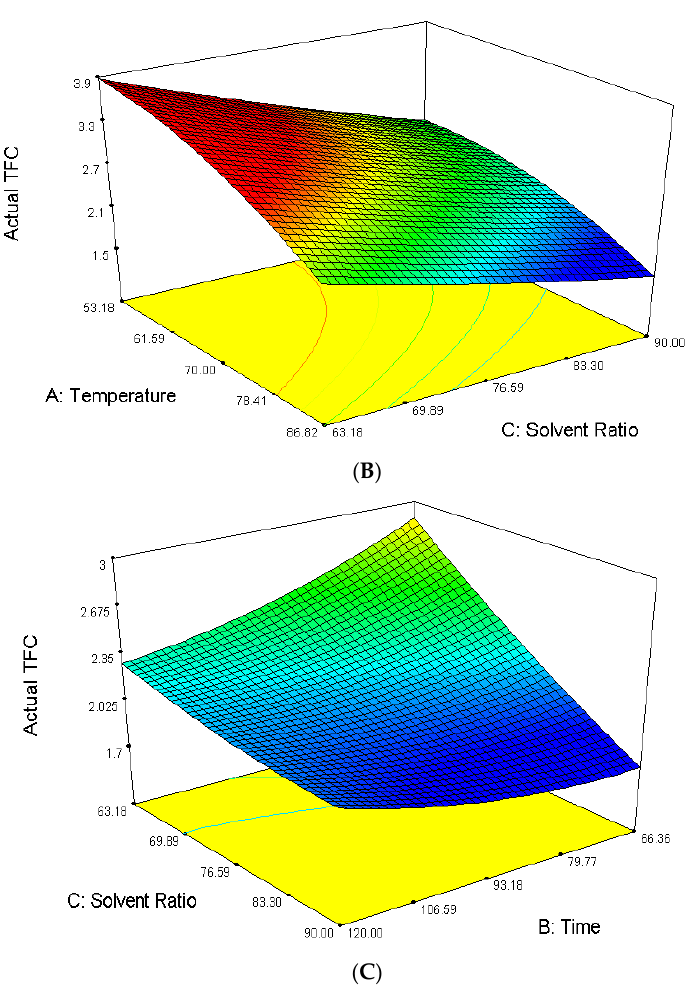
Figure 5. Response surface (3D) on the effect of extraction temperature, ethanol concentration and extraction time on TFC of P. macrocarpa fruit. ( A ) Total Flavonoid Content (mg/g); ( B ) Total Flavonoid Content (mg/g); ( C ) Total Flavonoid Content (mg/g).